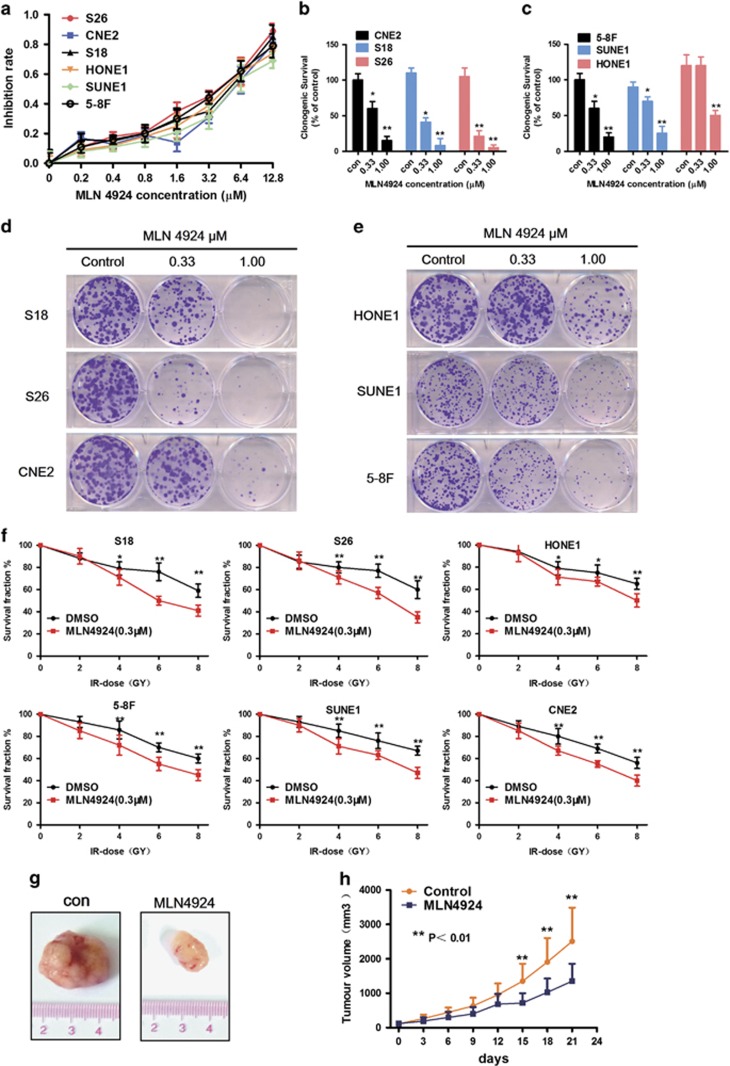
MLN4924 inhibits the growth of human NPC and sensitizes NPC cells to radiation. (a) The NPC cells were treated with various concentrations of MLN4924 for 72 h. Cell viability was assessed by MTT assay. mean±S.E.M., n=3. (b,c,d,e) The colony formation assays were performed in the indicated cell lines for MLN4924. The colonies with more than 50 cells were counted after 10–12 days. (f) The ability for colony formation upon various radiation doses combined with MLN4924. Cells were seeded in 60-mm dishes treated with MLN4924 for 6 h and then followed different dose of radiation as indicated. (g,h) MLN4924 significantly inhibited the growth of human NPC xenografts in vivo. Mice bearing S18 human NPC tumor xenografts were treated with HPBCD (as the non-treated control, n=9) or MLN4924 (30 mg/kg, n=9, subcutaneous injection) twice a day for 10 days. Tumor volumes and mice weights were measured every three day. Data are presented as means ±S.E.M. of three independent experiments. *P<0.05, **P<0.01